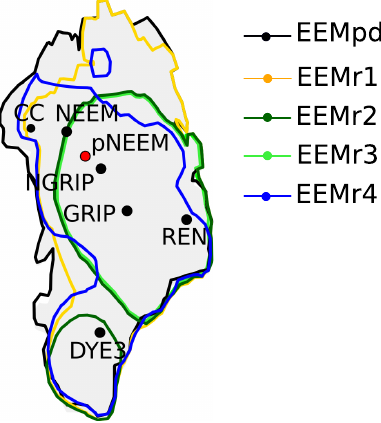
Figure 2. Greenland Ice Sheet margins in the Eemian sensitivity experiments illustrated as contour lines of 10% land ice coverage. The black dots indicate the locations of the ice core sites of Camp Century (CC), NEEM, NGRIP, GRIP, and DYE3. The red dot points at pNEEM, i.e., the supposed deposition site of Eemian ice found in the NEEM ice core according to NEEM community members